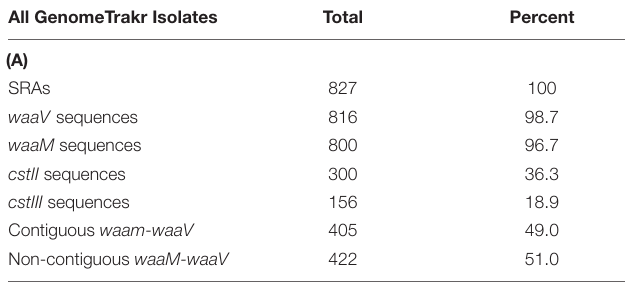
TABLE 3 | In silico analysis of 829 GenomeTrakr Sequence Read Archives (SRAs) from NCBI BioProject PRJNA258021. All GenomeTrakr